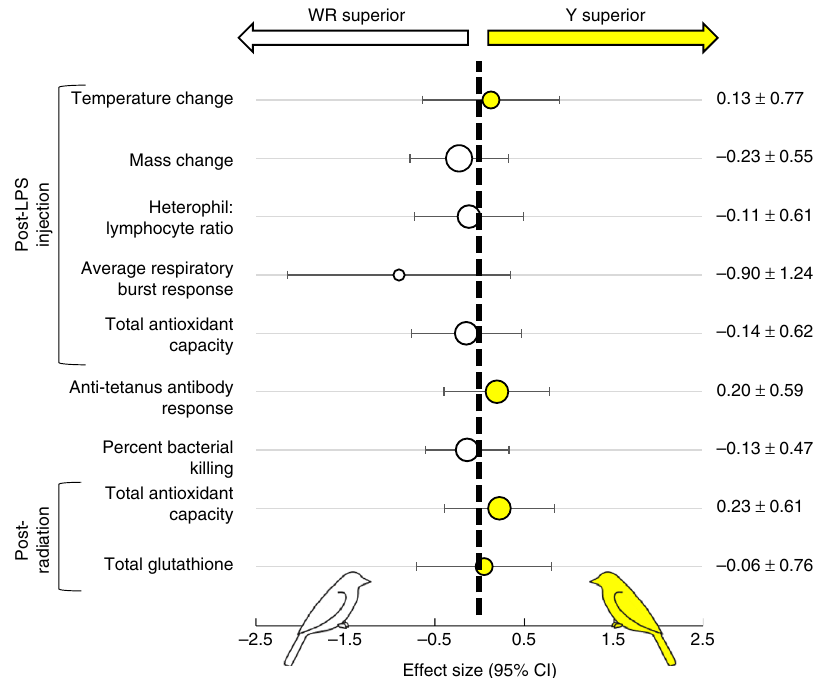
Fig. 2 Plots of effect sizes comparing physiological responses of white recessive and yellow canaries. Each point and error bar represents an effect size (Hedges ’ g ) and 95% con fi dence interval calculated from the average and standard error for a speci fi c physiological response by WR or Y. The size of the point is proportional to the sample size; sample sizes are listed in Supplementary Table 1. Points shifted to the left of the dashed center line (white points) indicate a stronger response by WR canaries, while points shifted to the right of the center line (yellow points) indicate a stronger response by Y canaries. All con fi dence intervals include an effect size of zero, re fl ecting that there are no statistically signi fi cant differences in any response between WR and Y canaries. Values listed in the right column indicate effect size ± 95% con fi dence interval. The respiratory burst assays were performed on only a subset of birds ( N = 11; see Methods), and the results should be interpreted with caution of that test should be viewed with